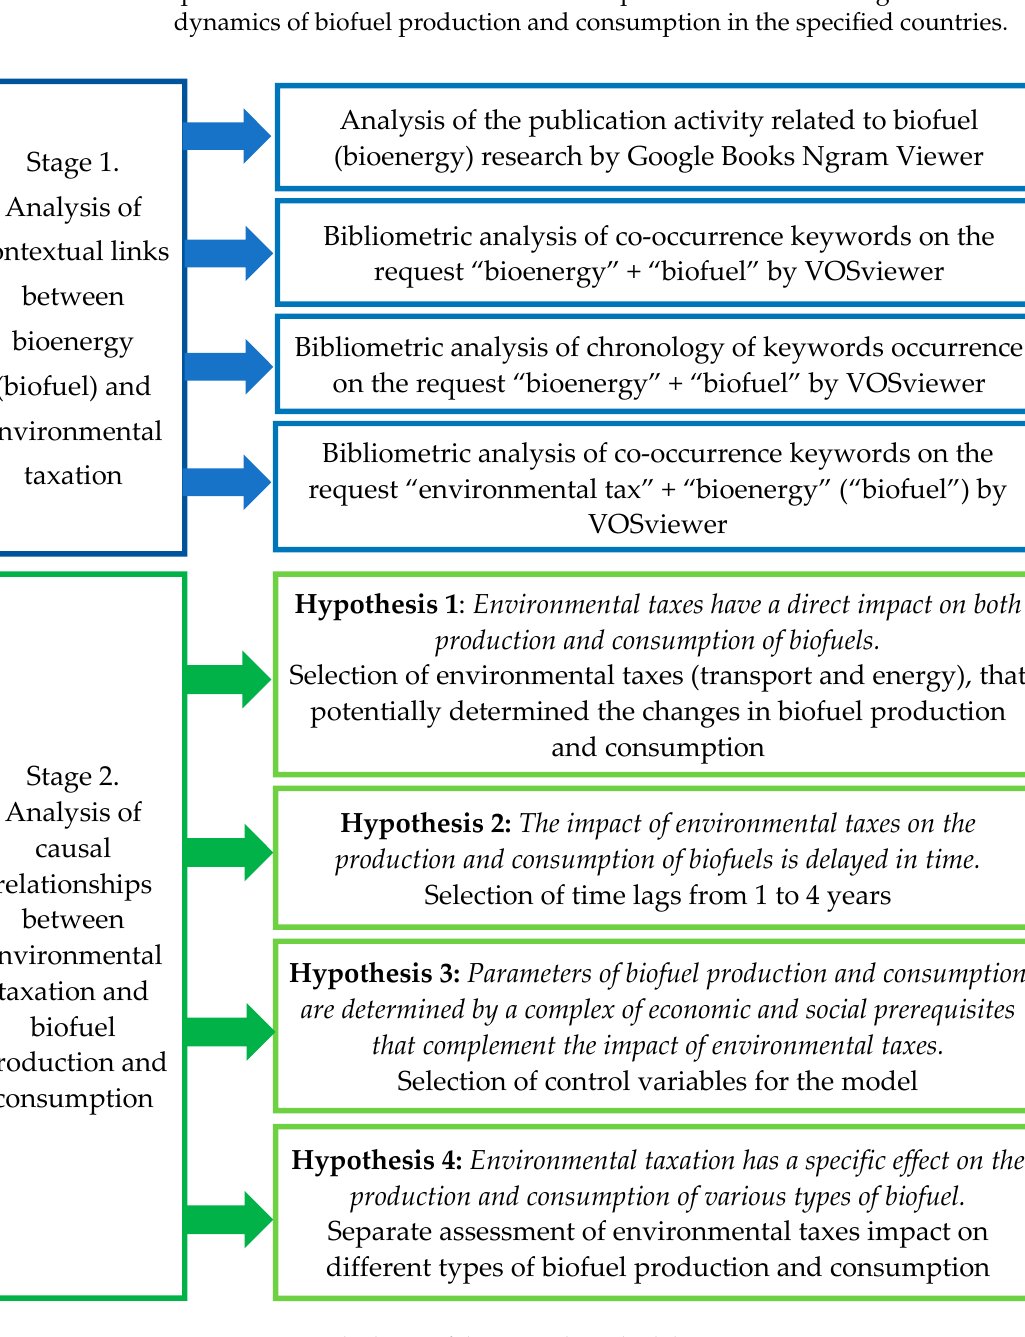
Figure 1. General scheme of the research